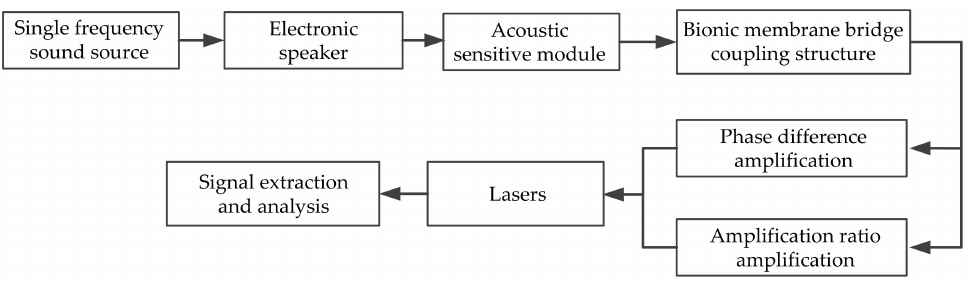
Figure 11. The experimental schematic in this paper.